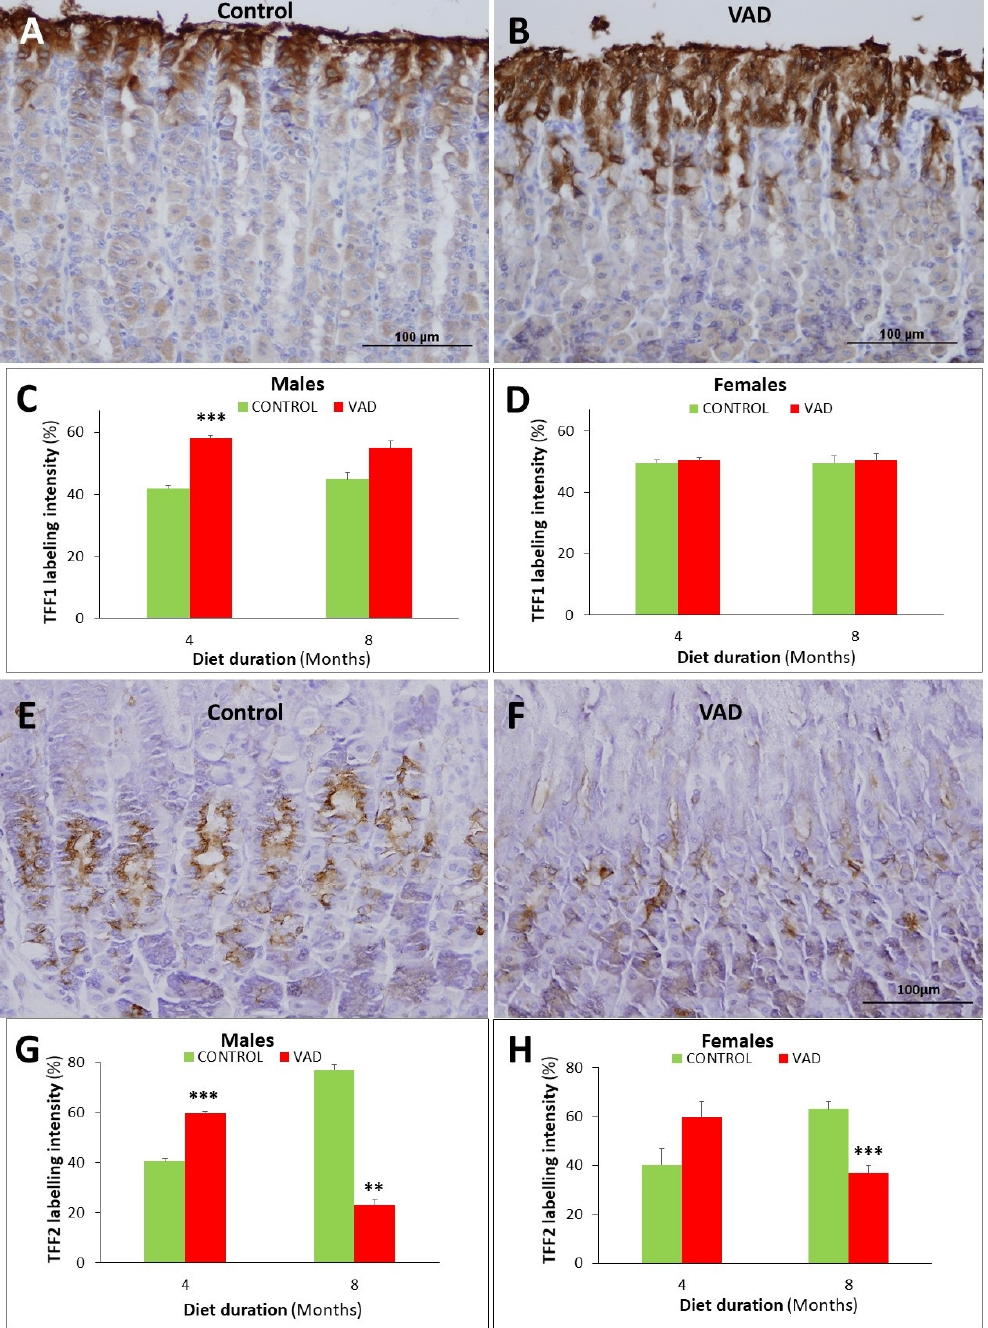
Figure 8. Immunolocalization and quantification of TFF1 ( A – D ) and TFF2 ( E – H ) in the gastric glands of control and VAD mice. Images are taken from 8-month control ( A , E ) and VAD ( B , F ) male mice. TFFs immunolabeled cells appear brownish. Cells expressing TFF1 are seen at the luminal surface and the gastric pits ( A ) and are more abundant in VAD tissues than in control ( B ). TFF2 is located in the cells of the neck segment of the gastric glands ( E ) and quantification demonstrates a decreased labeling intensity in VAD tissues ( F , H ). Data were presented as mean ± SE. Scale bars = 100 µm. ** p < 0.01, and *** p < 0.001.